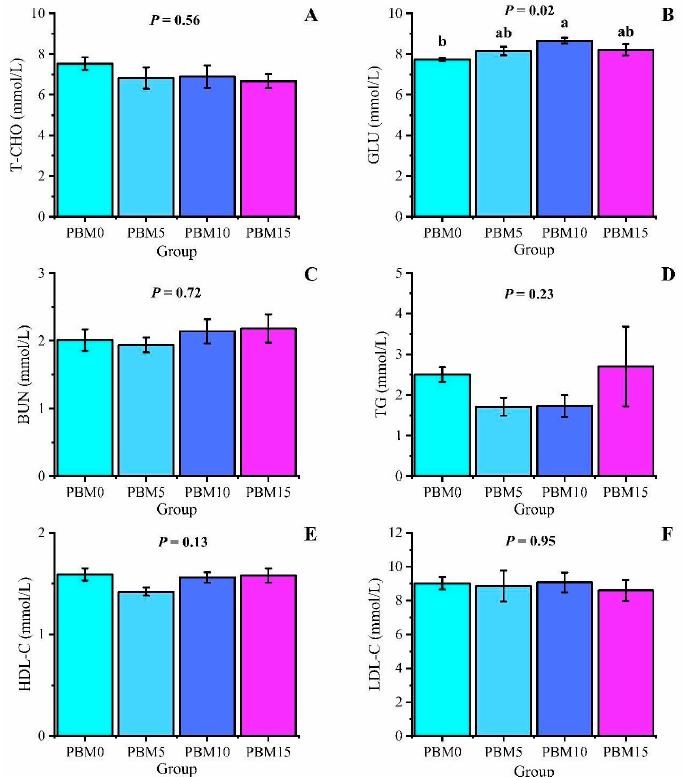
Figure 2. Effect of dietary replacement of fish meal with poultry by-product meal on the serum biochemical indicators of Chinese soft-shelled turtle. ( A ) T − CHO, total cholesterol; ( B ) GLU, glucose; ( C ) BUN, blood urea nitrogen; ( D ) TG, triglyceride; ( E ) HDL − C, high − density lipoprotein cholesterol; ( F ) LDL − C, low − density lipoprotein cholesterol; Error bars was represented the mean ± standard error (n = 6). Different letters indicated significant differences between groups ( p < 0.05).